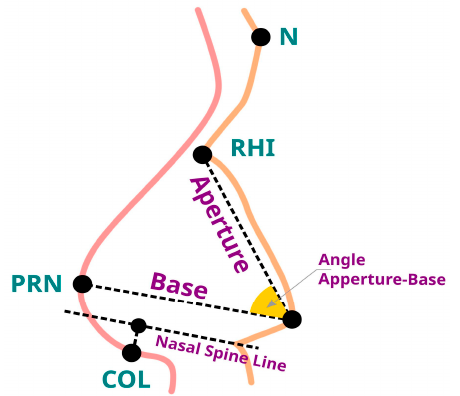
Figure 2. The study used the distance from the rhinion to the lateral border of the nose, called Aperture, and the distance between the pronasale and the lateral border, called the Base. Another distance measured was between the projected line from the lower nasal crest to the columella. With them, it was possible to stipulate the size of the Base from Aperture. The end of the Base is the pronasale, and the columella receives an average increment from the measurements